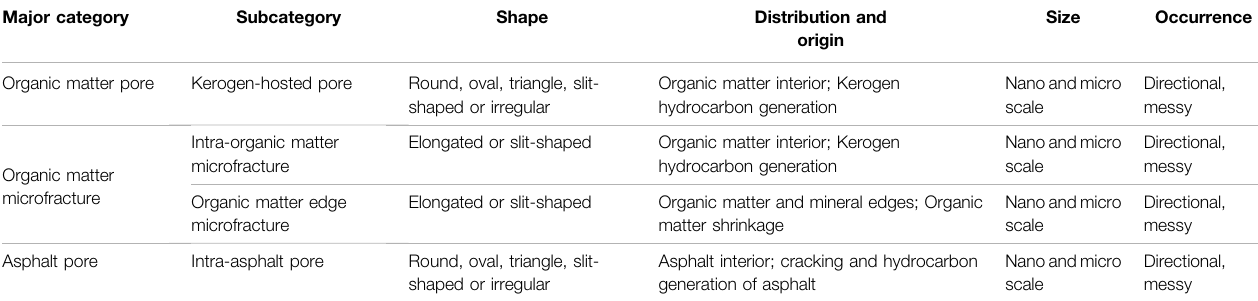
TABLE 3 | Classi fi cation of organic pore types in shale reservoirs.